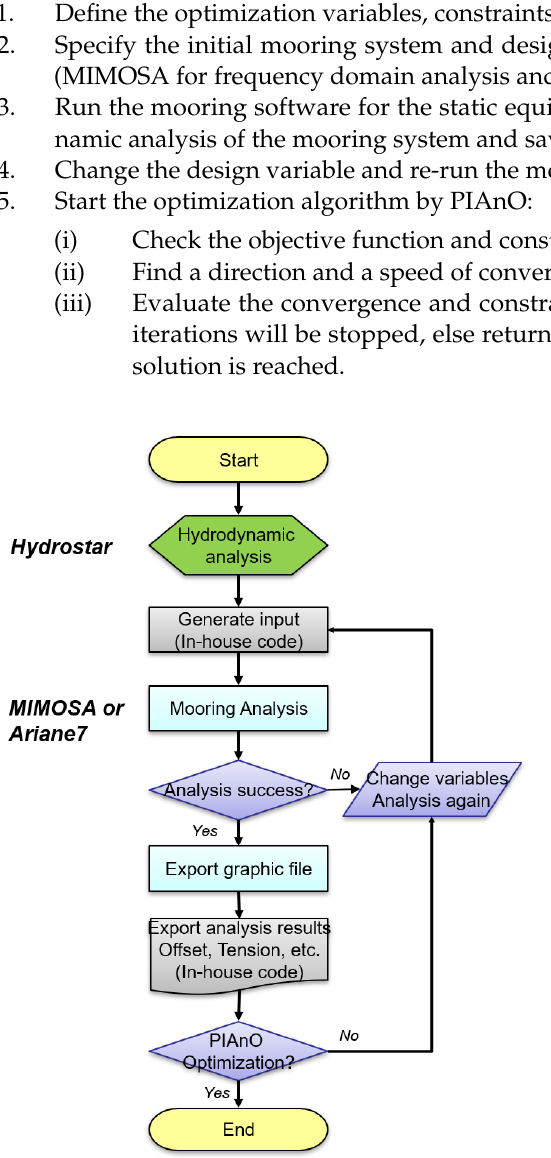
Figure 4. The overall flow chart of optimization and automation algorithm.